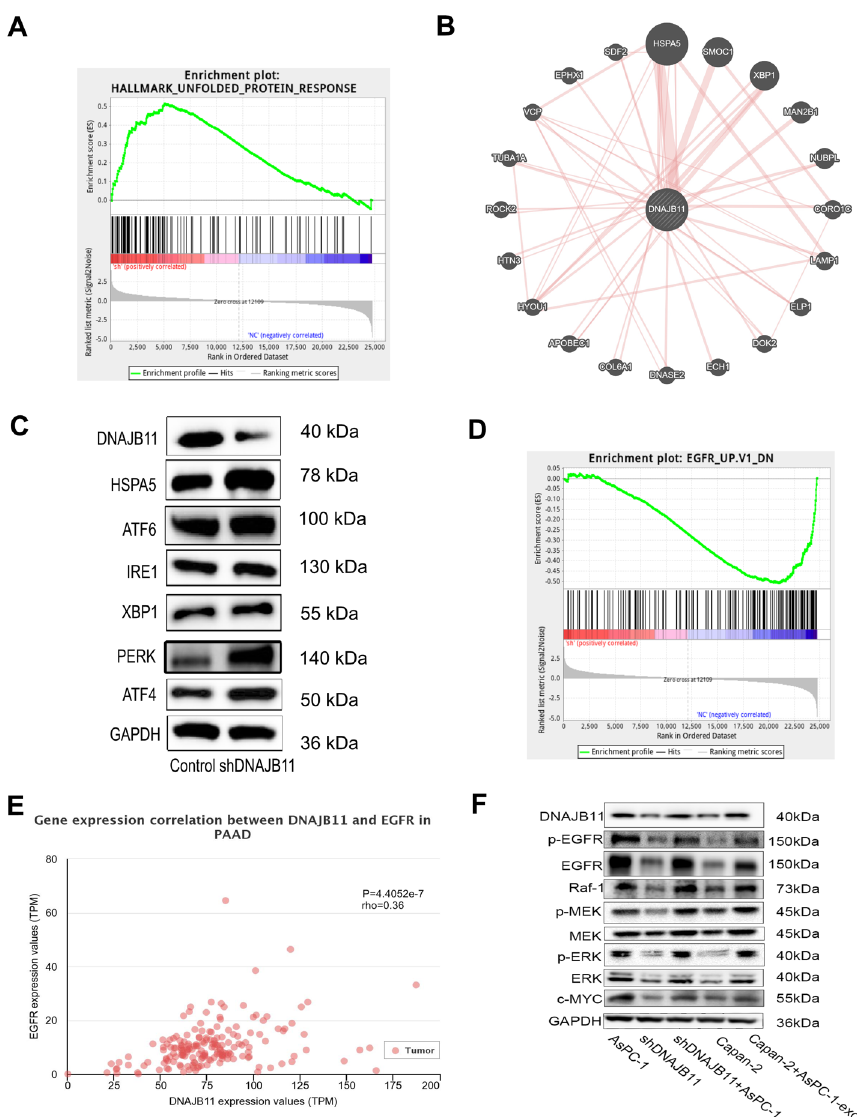
Fig. 6 DNAJB11 inhibited ER stress activity by the PERK-ATF4 pathway and induced the EGFR/MAPK pathway. A. The UPR pathway was upregulated in the WT group by GSEA. B Functional network integration was performed by GeneMANIA. C The protein levels of DNAJB11, HSPA5, ATF6, IRE1, XBP1, PERK, ATF4, and GAPDH were measured by western blot analysis. D EGFR was inhibited in the DNAJB11-knockdown group by GSEA. E Correlation analysis of DNAJB11 and EGFR by UALCAN. F After incubation with exosomes, the protein levels of DNAJB11, EGFR, p-EGFR, Raf-1, MEK, p-MEK, ERK1/2, p-ERK1/2, c-MYC, and GAPDH were measured by western blot